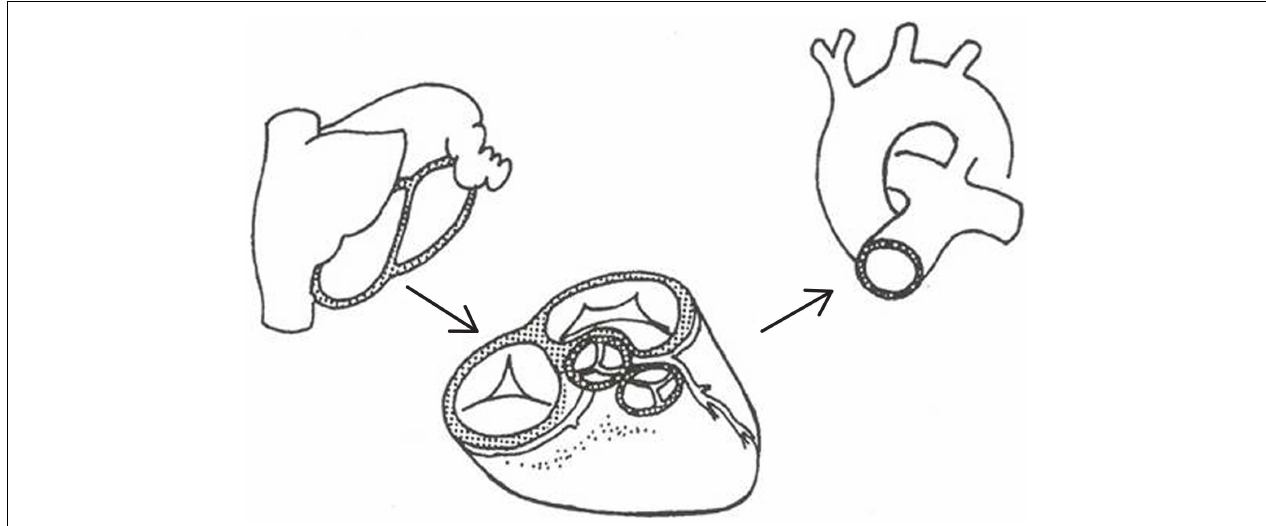
FIGURE 1 | Segmental analysis of congenital heart disease .The normal heart consists of three segments: atria, ventricles, and the great arteries connected each other at atrioventricular and ventriculo-arterial junctions [partially modified from Refs. (12, 13)].